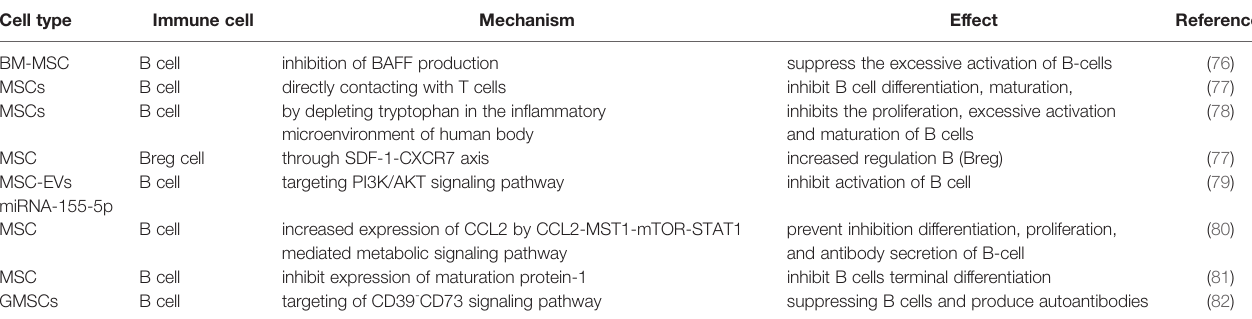
TABLE 2 | Mechanism of action with MSCs and EVs on B